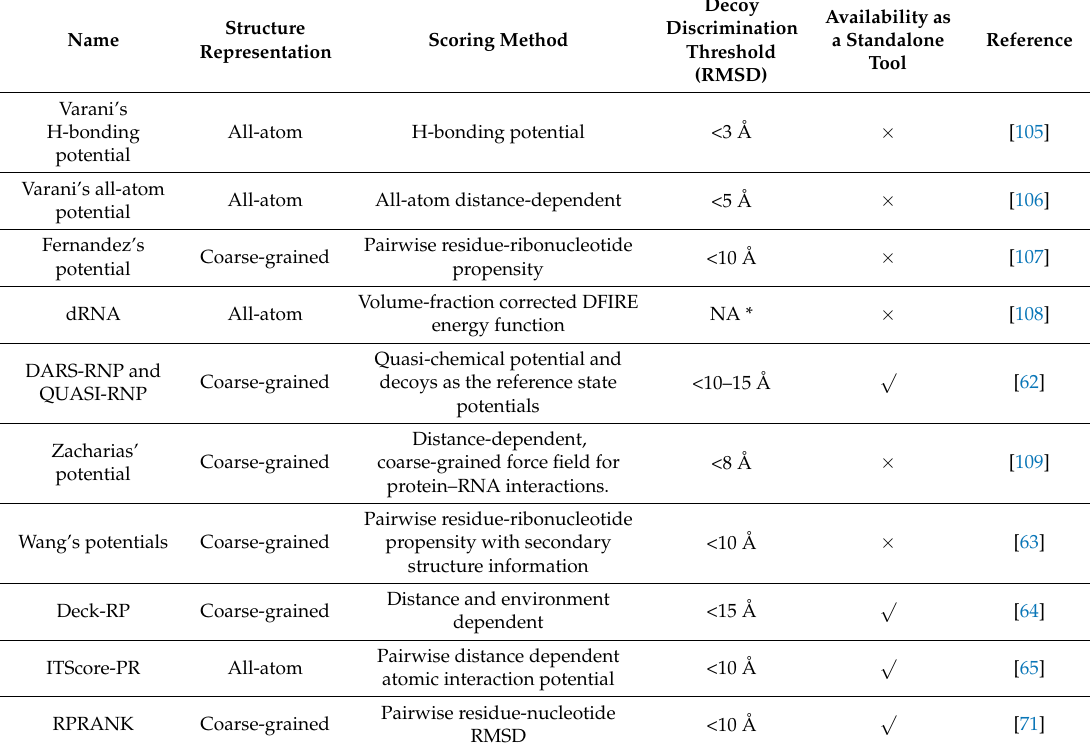
Table 2. List of scoring methods for RNP docking. The representation of the molecules (all-atom or coarse-grained), the type of statistical function and the availability of these methods (web server and/or standalone) have been listed in this